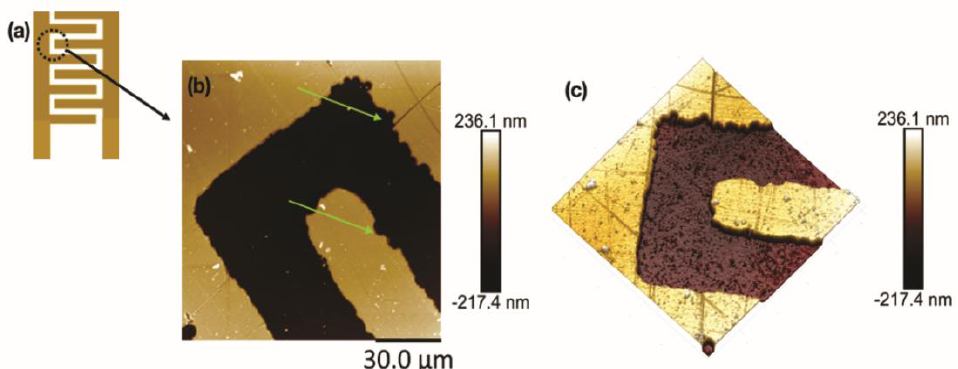
Figure 5. Atomic Force Microscopy topographic images of the interdigital region of the sensor. ( a ) Schematic figure of the sensor architecture. The AFM image was obtained in the region highlighted by the circle. ( b ) AFM height image showing the electrode surface and a digit. The green arrows indicate defects in the deposited layer. ( c ) Three-dimensional image corresponding to the image ( b ). One can observe the grooves on the electrode surface due to the deposition process.